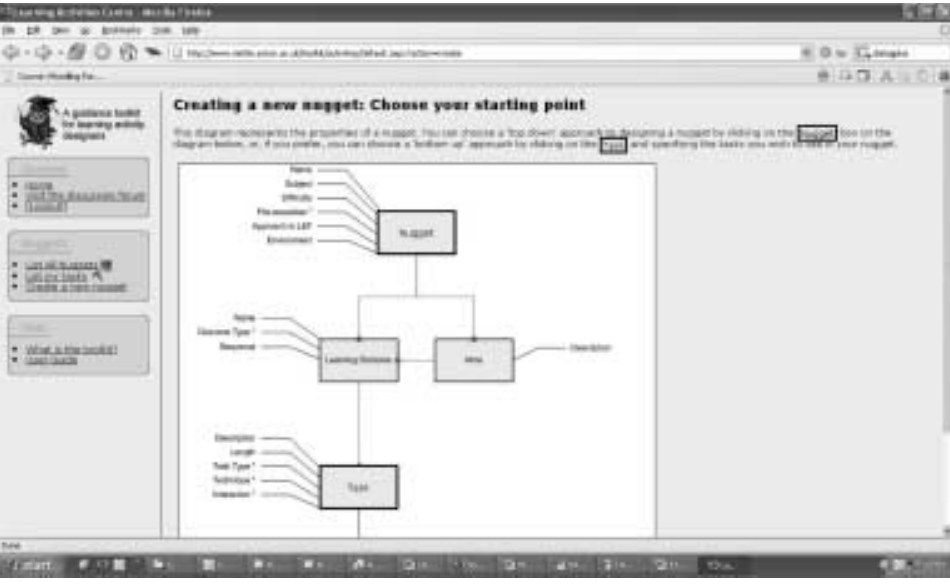
Figure 1. Screenshot of the DialogPlus toolkit intended to help practitioners design technology enhanced learning activities (http://www.nettle.soton.ac.uk/toolkit/activities/default.aspx?action=